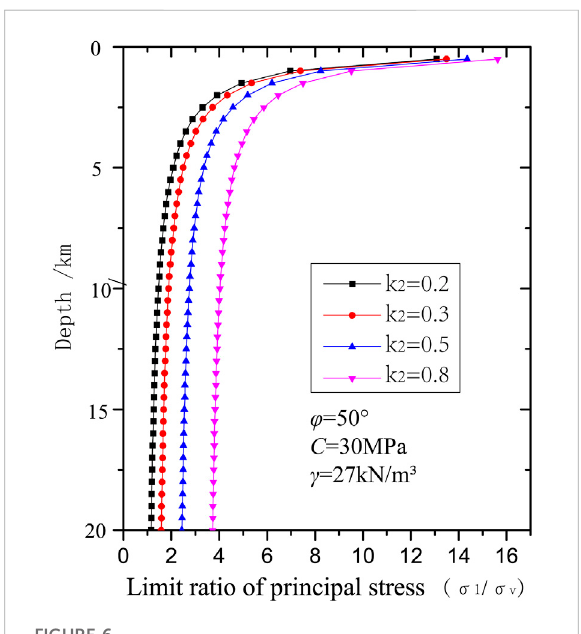
FIGURE 6 Distribution of principal stress ratio under different k 2